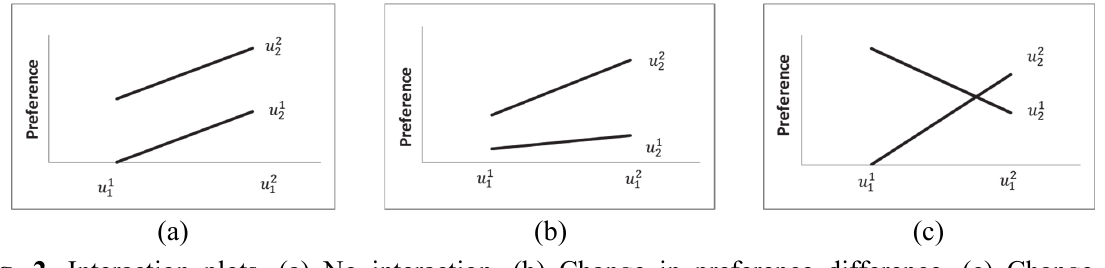
Fig. 2. Interaction plots. (a) No interaction. (b) Change in preference difference. (c) Change in